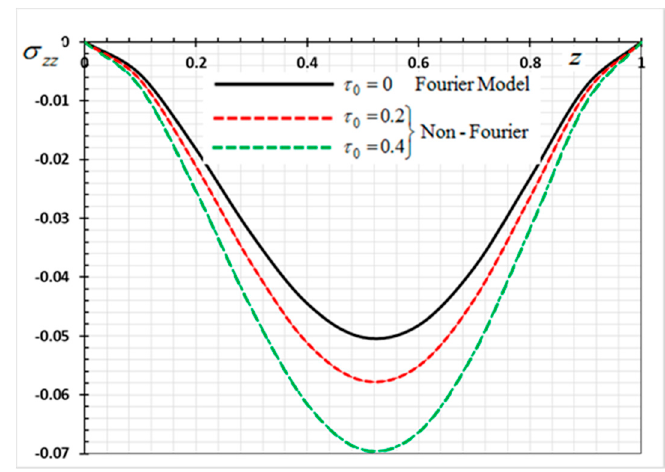
Figure 18 . Variation of displacement w versus z for Fourier and non-Fourier models.